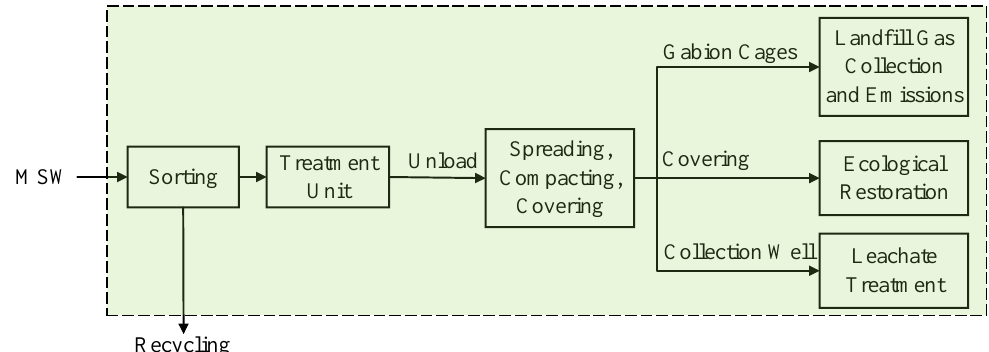
Figure 2. Schematic processing flowchart of municipal solid waste (MSW) sanitary landfill. [70].